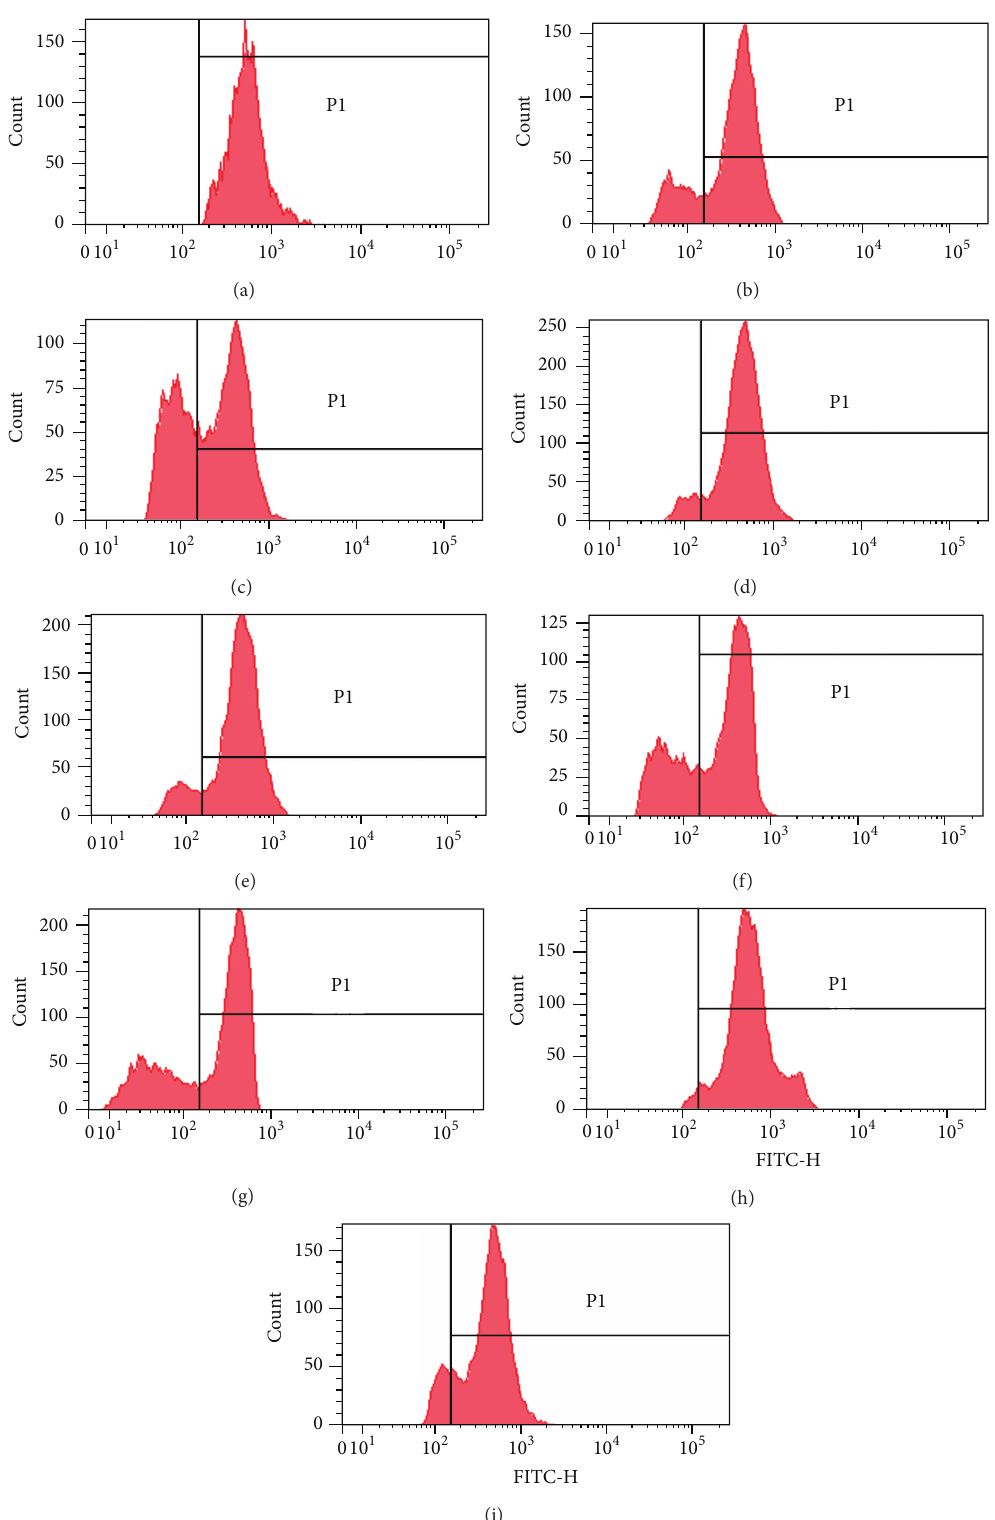
Figure 2: Fluorescence histogram of the phagocyte capacity of MG-63 cell line after treatment with different NSAIDs at doses of 1 and 10 𝜇 M in comparison to control, determined by means of flow cytometry. (a) Control; (b) dexketoprofen 1 𝜇 M; (c) dexketoprofen 10 𝜇 M; (d) ketorolac 1 𝜇 M; (e) ketorolac 10 𝜇 M; (f) metamizole 1 𝜇 M; (g) metamizole 10 𝜇 M; (h) acetylsalicylic acid 1 𝜇 M; (i) acetylsalicylic acid 10 𝜇 M. These results are an example of one